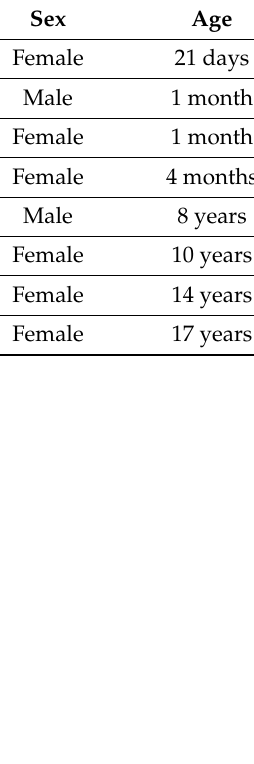
Table 4. Involved drugs with off-label use in adverse drug reactions